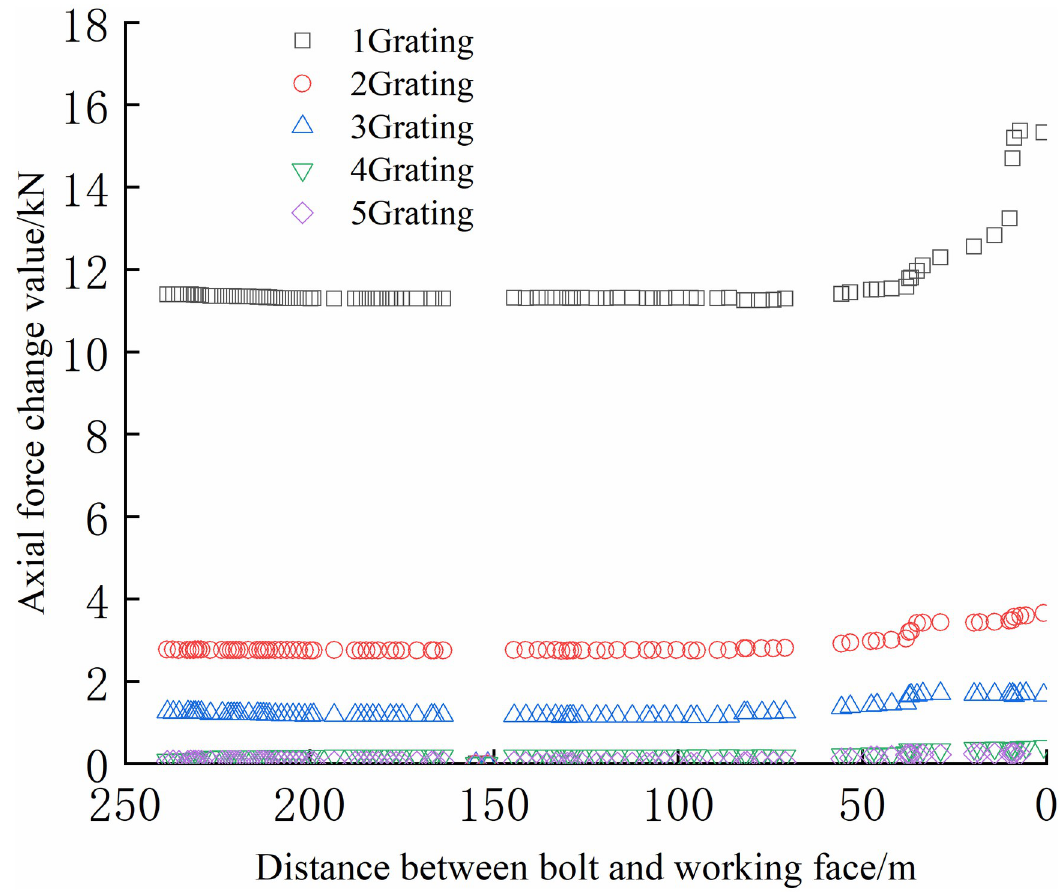
Fig 31. Axial force monitoring test curve of No. 8 bolt.